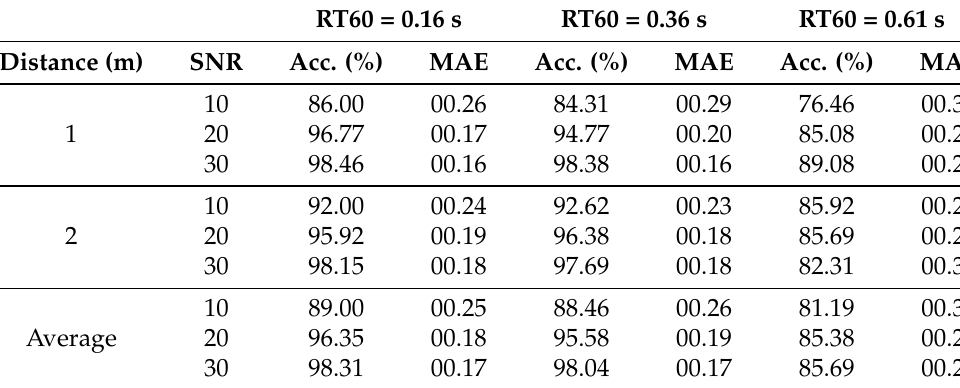
Table 7. Performance of distance estimation by CNN-R in a multiple acoustic environment at SNRs of 10, 20, and 30 dB, respectively.